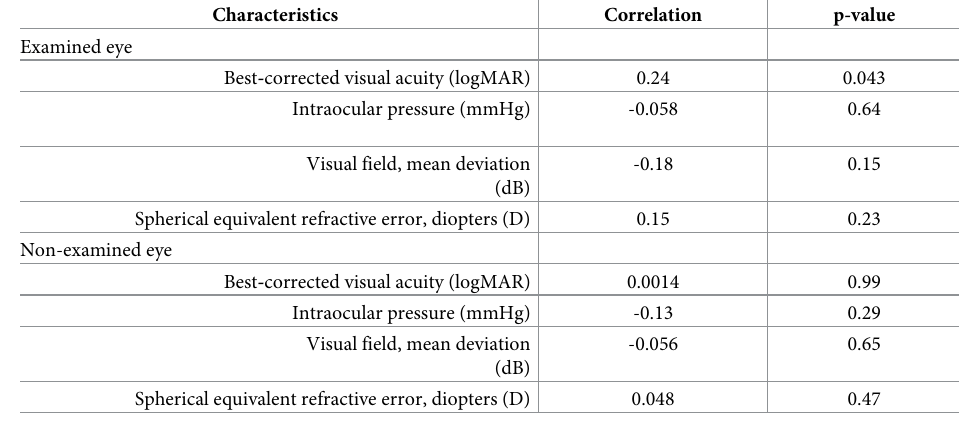
Table 3. Correlation between the examination time of GS-1 and clinical characteristics of the